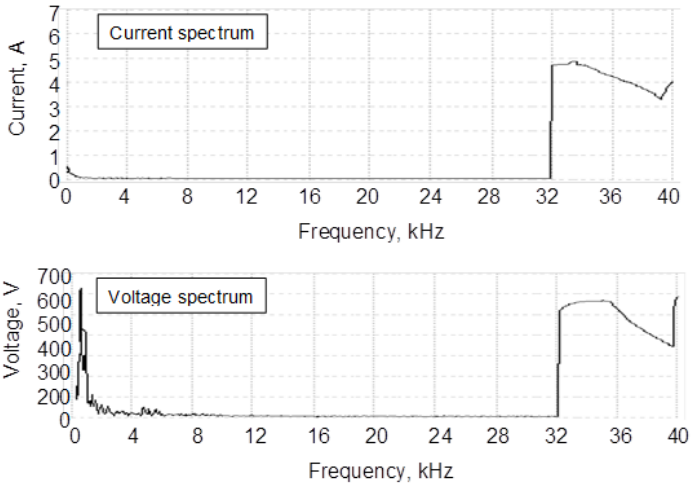
Figure 5. Typical Fourier spectra of the high-frequency power supply’s voltage and current